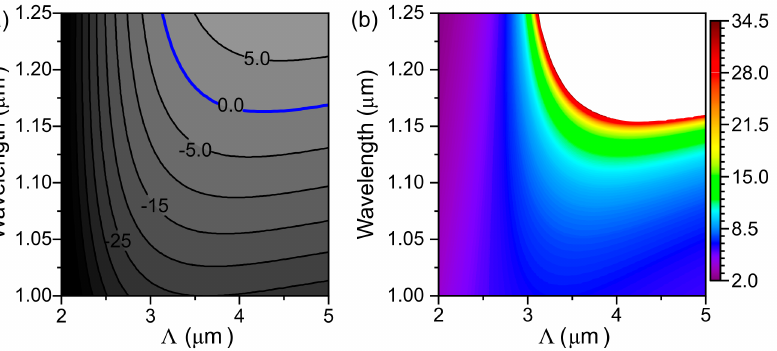
Figure 3. ( a ) Chromatic dispersion as a function of optical wavelength and fiber pitch for ethanol- filled PCFs. Numbers indicates dispersion levels in ps/km · nm. ( b ) Frequency shift map of PMI–SF; color bars are detuning frequencies values in THz. Parameters used in the simulations: d/ Λ = 0.58, P = 3 kW.